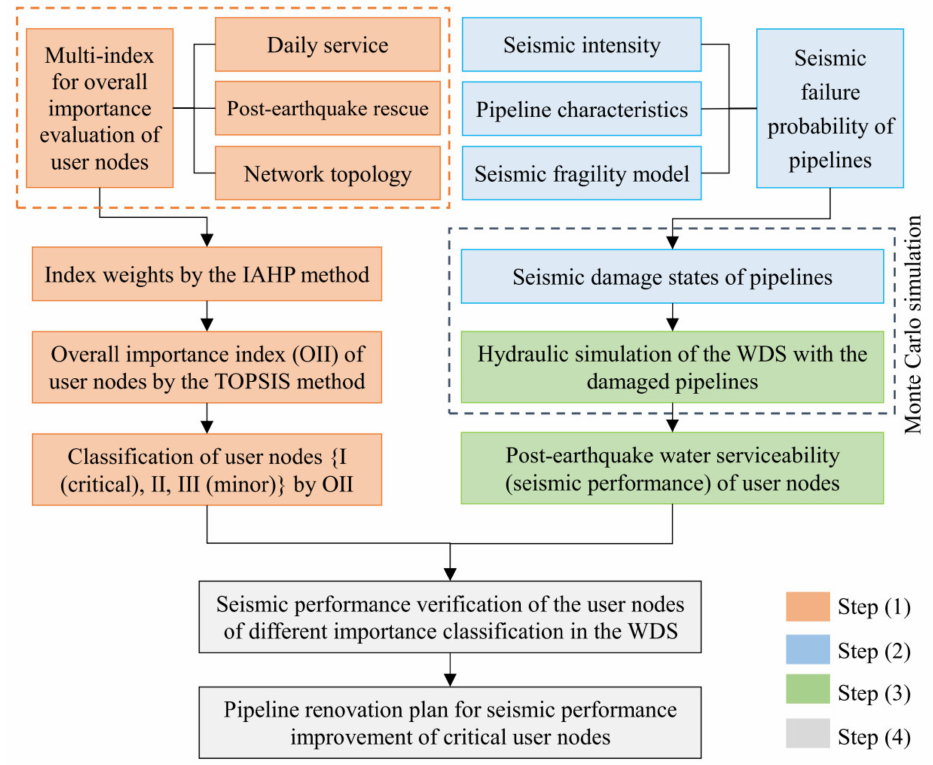
Figure 1. The framework for seismic performance evaluation of WDS based on nodal